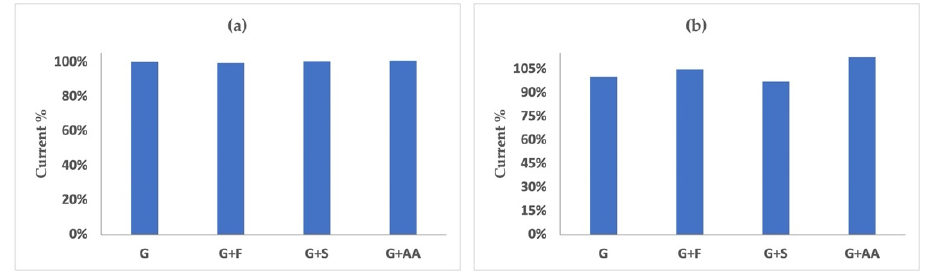
Figure 6. Effect of fructose (F), saccharose (S), and ascorbic acid (AA) on the current value in a 0.2 mM ( a ) and 2.0 mM ( b ) glucose (G) solution; the glucose:interferent ratios are equal to 1:1, 1:0.6, and 1:0.05, respectively.